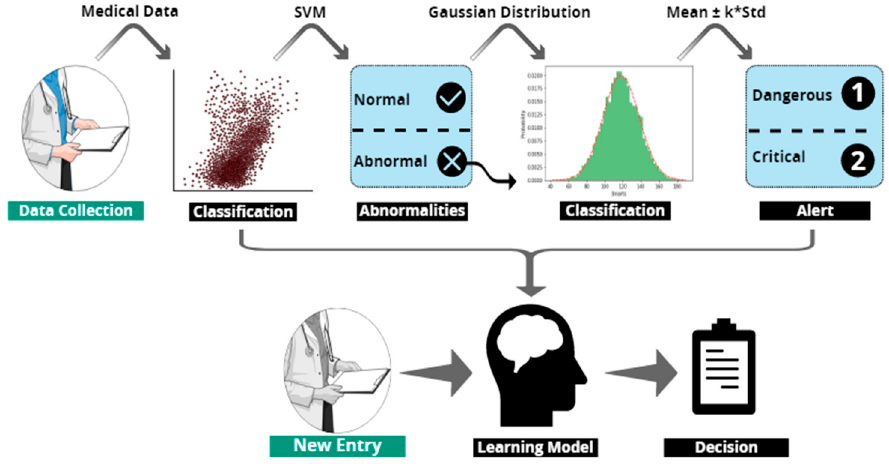
Figure 16. Illustration of the general process of designing our model.